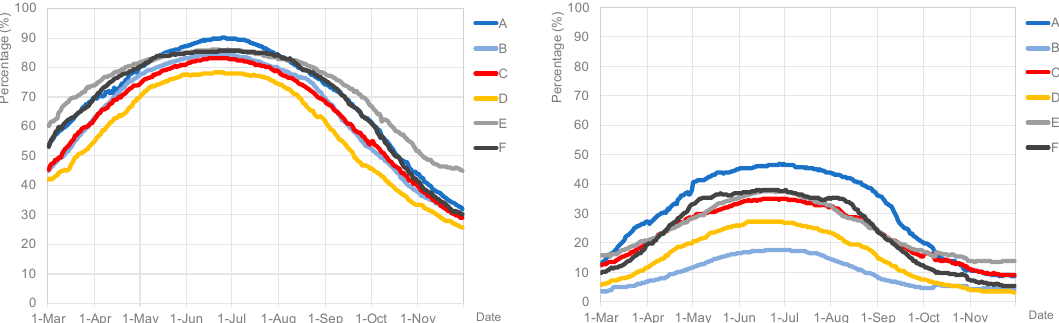
Figure 7. Percentages of ground-level surface with direct sunlight for three or more hours ( left ) and six or more hours ( right ) from March to November for study sites A to F when FAR is 2.0.